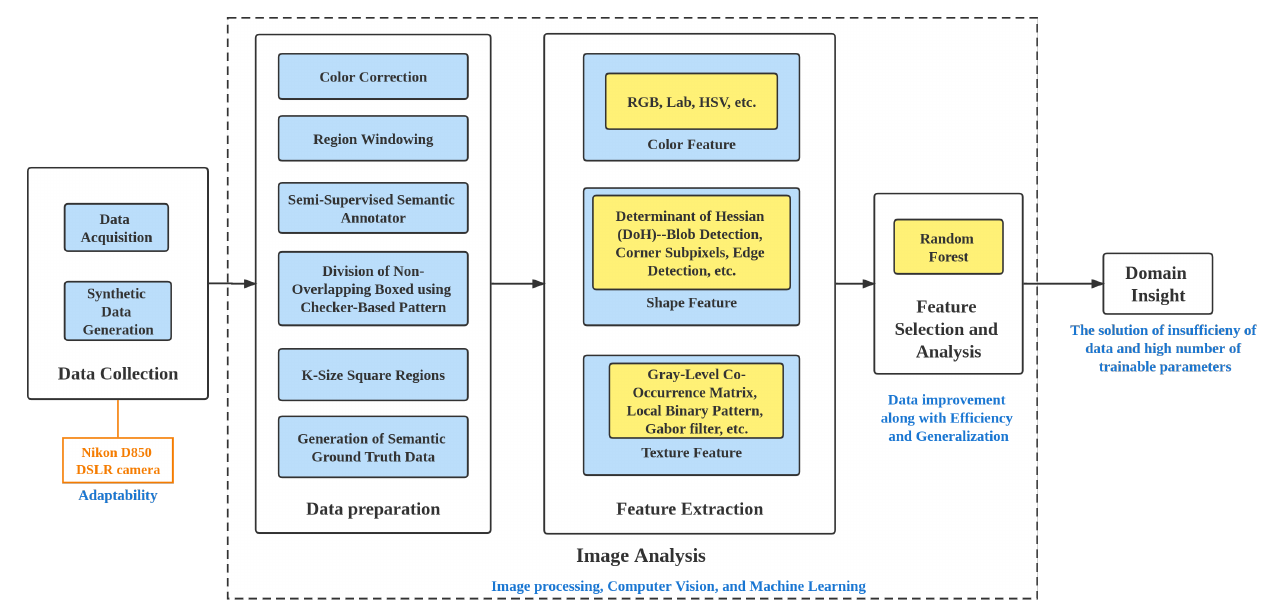
Figure 2. The processing